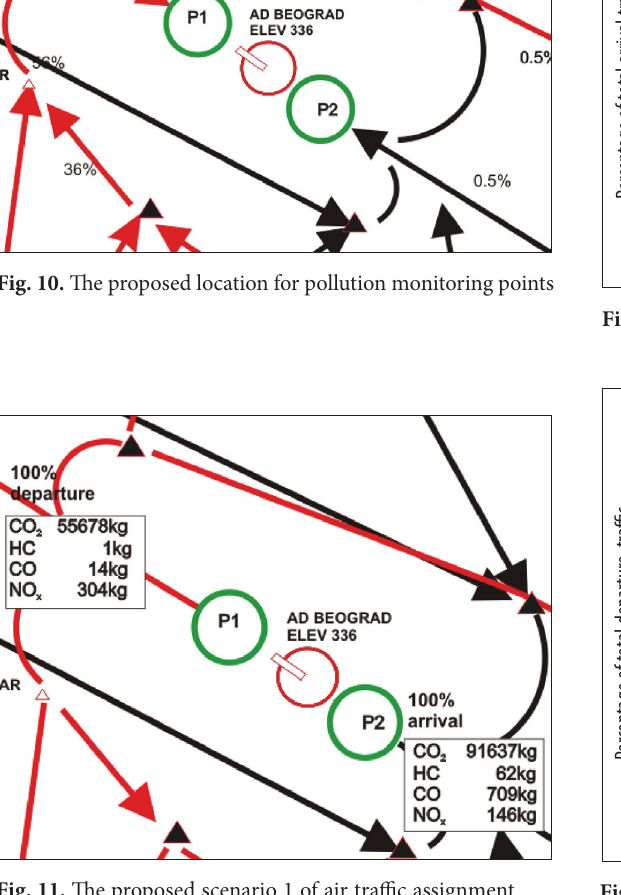
Fig. 14. Departure traffic distribution for balanced